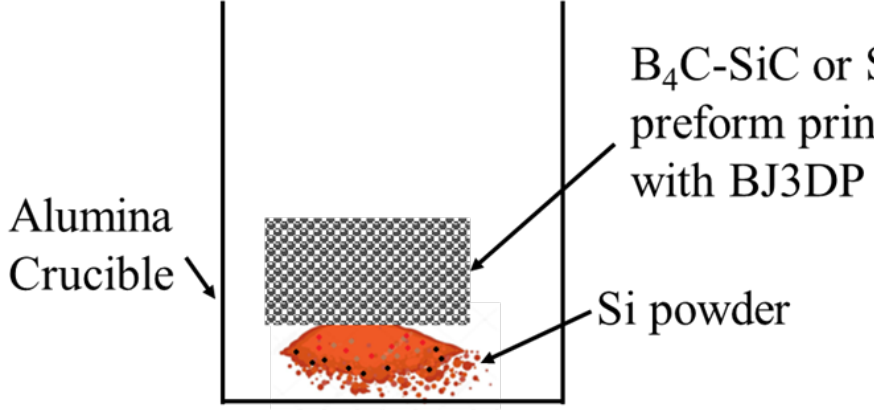
Figure 1. A schematic of the infiltration setup for printed